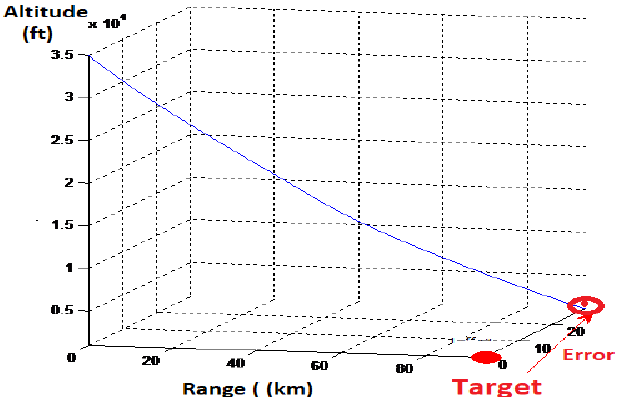
Figure 9. UAV trajectory: LQR based stabilization control architecture.